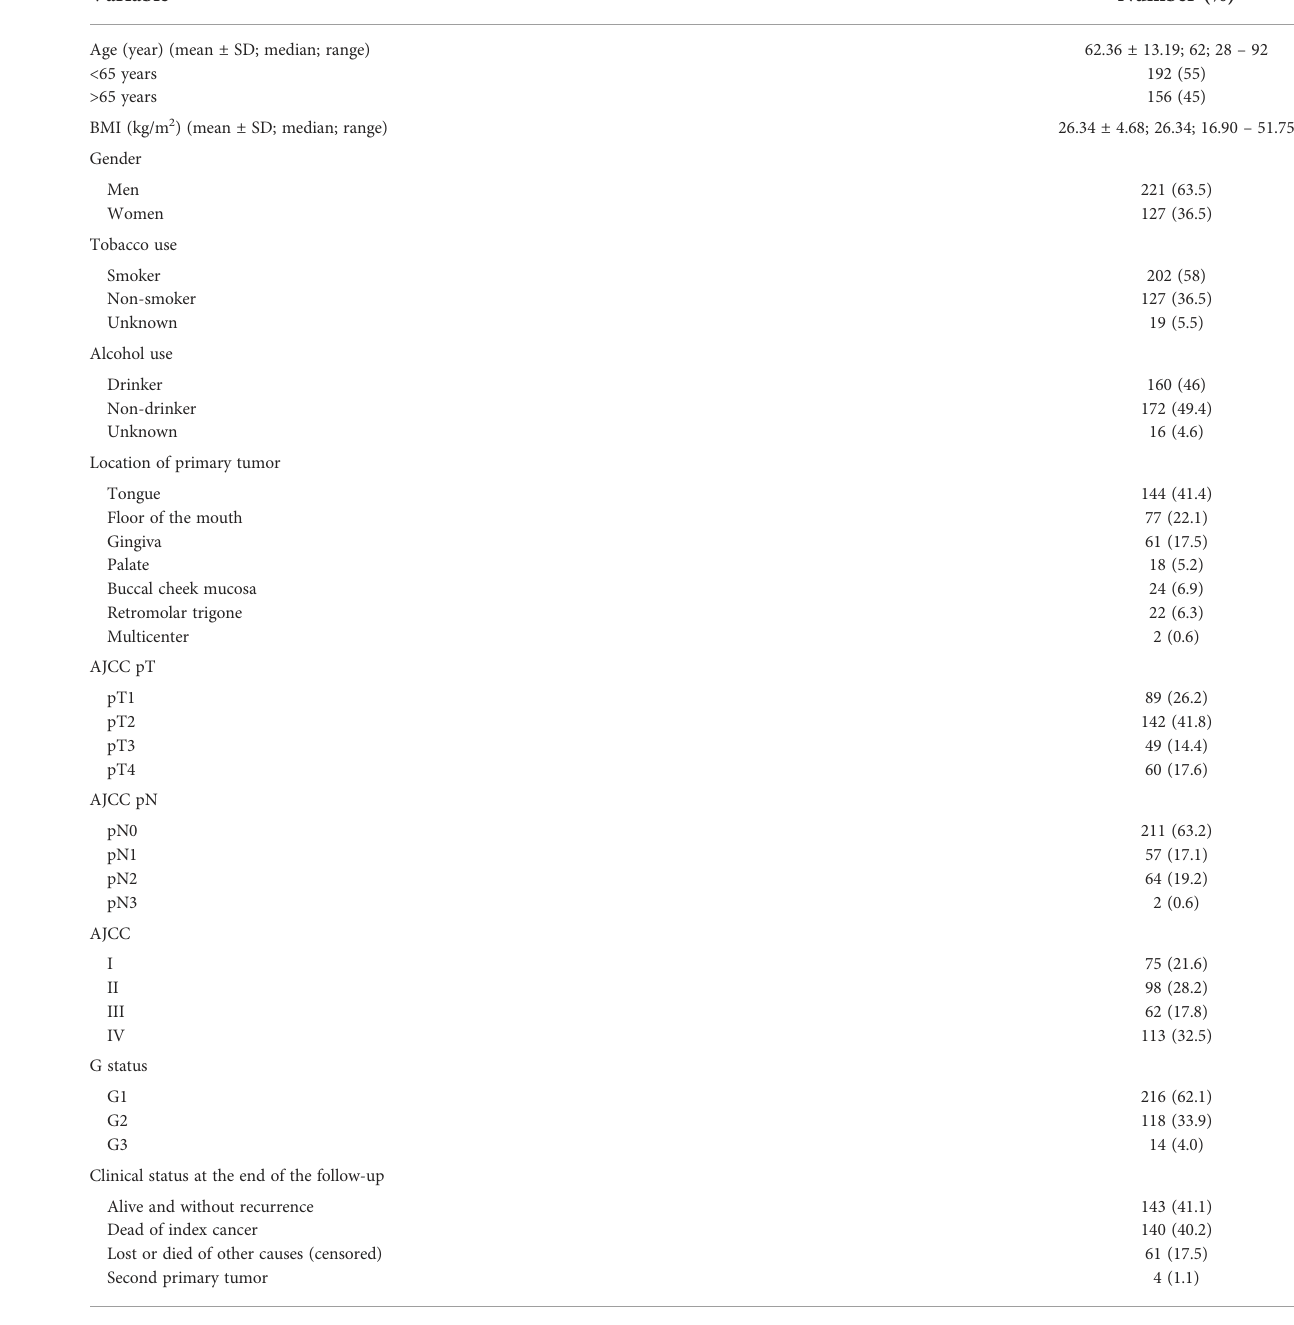
TABLE 1 Clinical and pathological characteristics of the cohort of 348 OSCC patients selected for study.